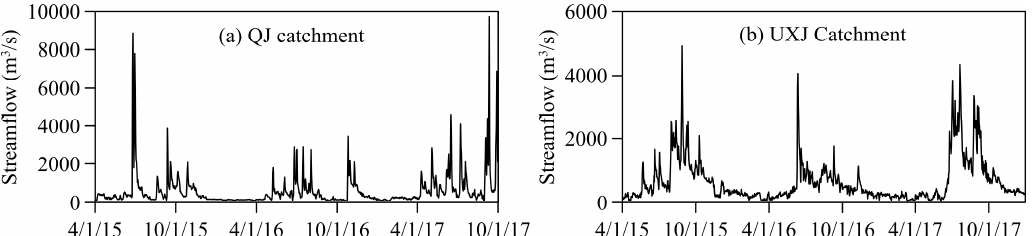
Figure 2. Observed daily streamflow at the outlet of the ( a ) Qujiang and ( b ) Upper Xijiang catchments.